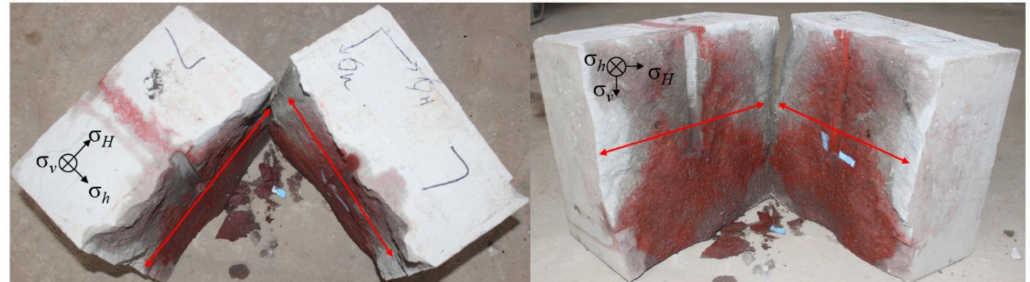
Figure 3. Hydraulic fracture geometry of sample C-1.